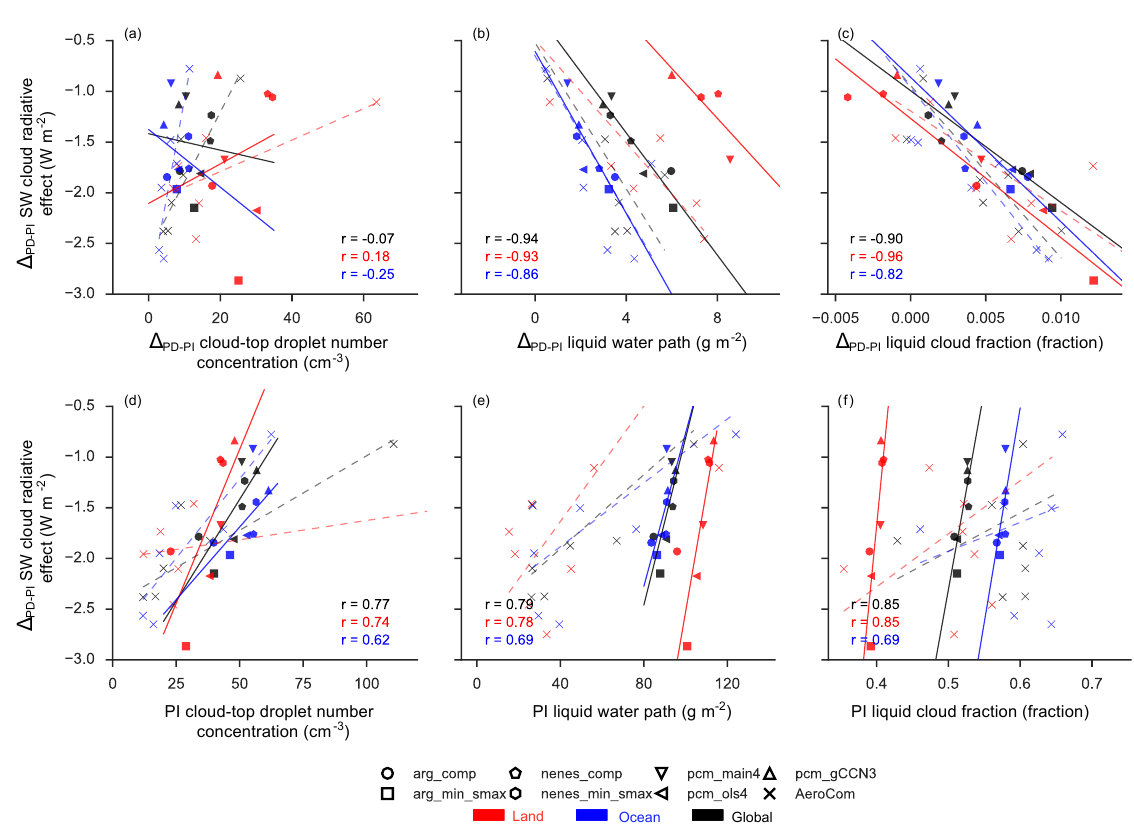
Figure 12. Similar to Fig. 9; panels (a) – (c) denote the relationship between PD–PI changes in SW CRE and cloud properties, and panels (d) – (f) show regression versus averages from the PI emissions